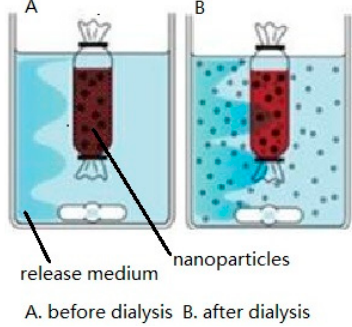
Figure 1. Positive dialysis method ( A , B ).